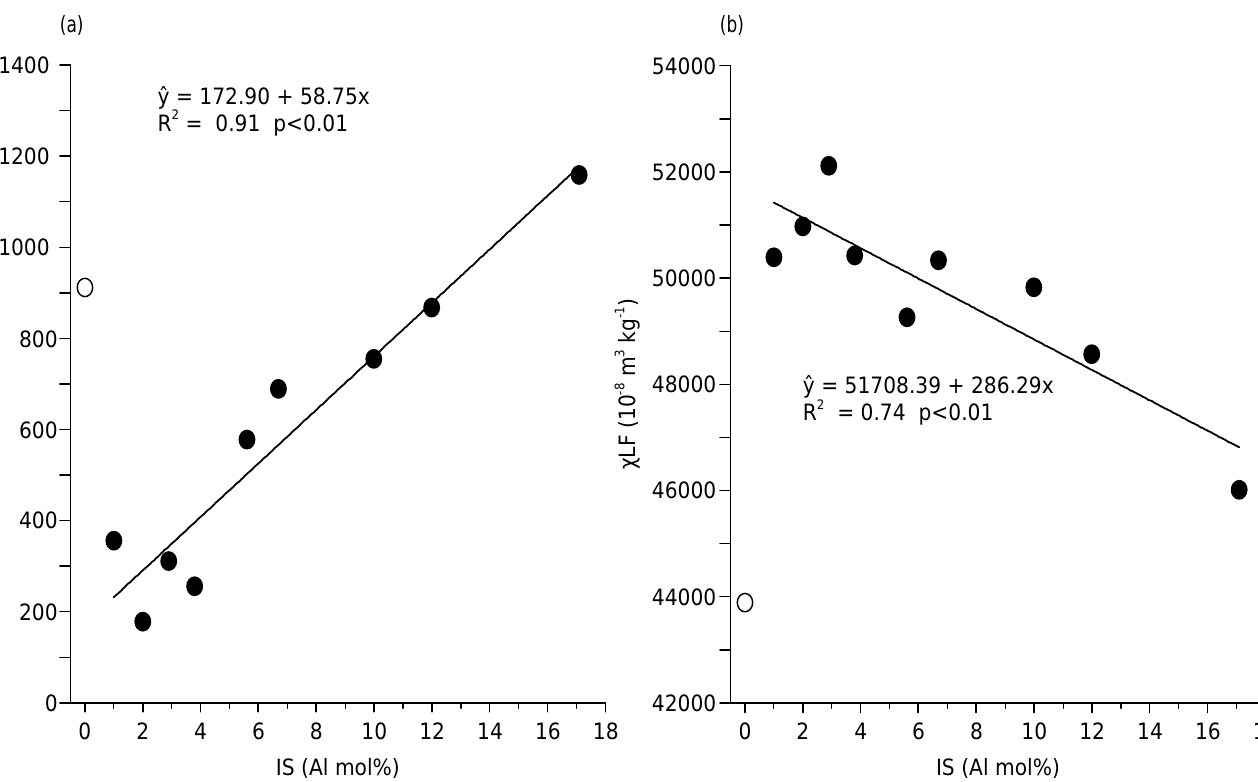
Figure 4. Mass specific magnetic susceptibility (χ LF ) values to synthetic Al-substituted maghemites (a) and hematites (b) samples. (○)